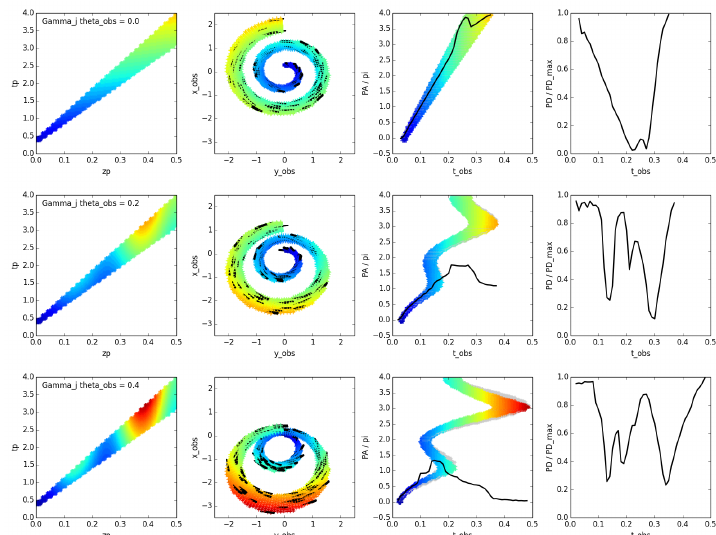
Figure 2. Polarisation signal calculated from my model of helical perturbation propagating within a relativistic conical jet for the case of a toroidal magnetic field. The first column shows the emission pattern in co-moving coordinates t (cid:48) vs. z (cid:48) with colour indicating the observed time t obs . The second column shows the emission pattern in apparent image coordinates x obs vs. y obs . The third column shows the observed polarization angle χ E vs. t obs . The black line shows the effective observed signal integrated over t obs bins, and the gray area shows the intrinsic polarization angle (PA) χ (cid:48) The fourth column shows the effective observed polarisation degree (PD) Π . The rows correspond to different values of the viewing angle θ obs = ( 0,0.2,0.4 ) / Γ j . Key parameter values are Γ j = 5, Θ j = 0.1, β p = 0.7.